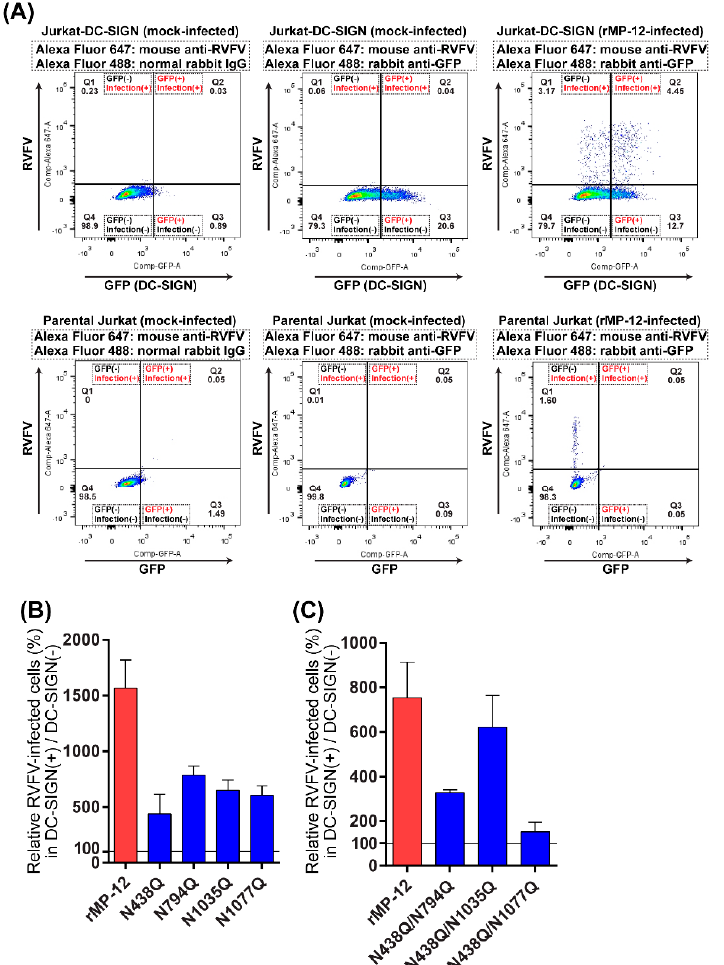
Figure 4. Infectivity of recombinant MP-12 encoding a glutamine (Q) in place of an asparagine (N) at N-X-S/T sequon(s) in Gn or Gc. ( A ) Jurkat-DC-SIGN cells stably co-expressing green fluorescent protein (GFP) and human DC-SIGN (~17% in cell population) (top panels), or parental Jurkat cells, which express neither DC-SIGN nor GFP (bottom panels), were mock-infected (left and center panels) or infected with rMP-12 (right panels) at a multiplicity of infection (MOI) of 3.6. At 6 hpi, cells were fixed, permeabilized, and then stained with a cocktail of mouse anti-RVFV antibody and Alexa Fluor 488-conjugated rabbit anti-GFP antibody, or a cocktail of mouse anti-RVFV antibody and Alexa Fluor 488-conjugated normal rabbit IgG. Subsequently, cells were stained with Alexa Fluor 647-conjugated goat anti-mouse IgG, and analyzed by flow cytometry. Since permeabilized Jurkat-DC-SIGN cells showed poor intrinsic GFP signals, as shown with Alexa Fluor 488-conjugated normal rabbit IgG (left top panel), rabbit anti-GFP antibody (center and right top panels) was used to detect GFP signals of permeabilized Jurkat-DC-SIGN cells. Q1, GFP-negative (DC-SIGN-negative) and RVFV-infected cell population; Q2, GFP-positive (DC-SIGN-positive) and RVFV-infected cell population; Q3, GFP-positive (DC-SIGN-positive) and uninfected cell population; Q4, GFP-negative (DC-SIGN-negative) and uninfected cell population; ( B , C ) Jurkat-DC-SIGN cells were infected with rMP-12 or that lacking one ( B ) or two sequons ( C ). Relative number of RVFV-infected cells in the GFP-positive cell population (Q2/(Q2+Q3)) normalized to that of RVFV-infected cells in the GFP-negative cell population (Q1/(Q1+Q4)) are shown. Graphs represent mean + standard deviations for three independent experiments. Both Jurkat ‐ DC ‐ SIGN and parental Jurkat cells could be infected with rMP ‐ 12 (Figure 4A, right top and right bottom panels). Thus, it was important to analyze viral infection via DC ‐ SIGN, over the nonspecific viral infection in Jurkat cells. To analyze viral infection via DC ‐ SIGN, relative number of